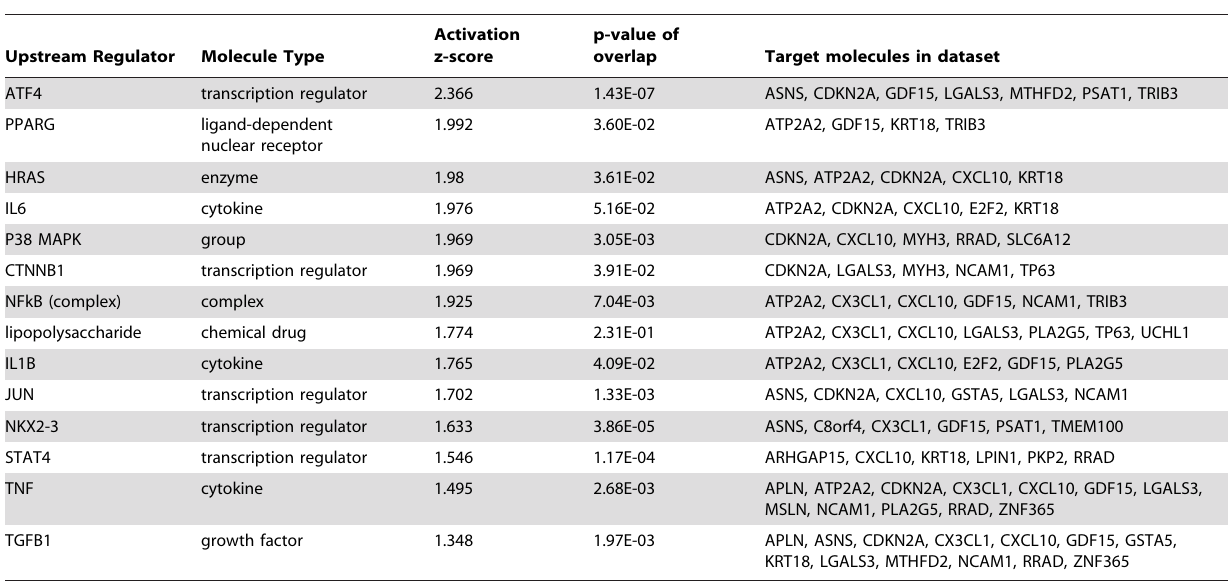
Table 1. Upstream analysis by IPA of altered genes of old TauTKO muscle.